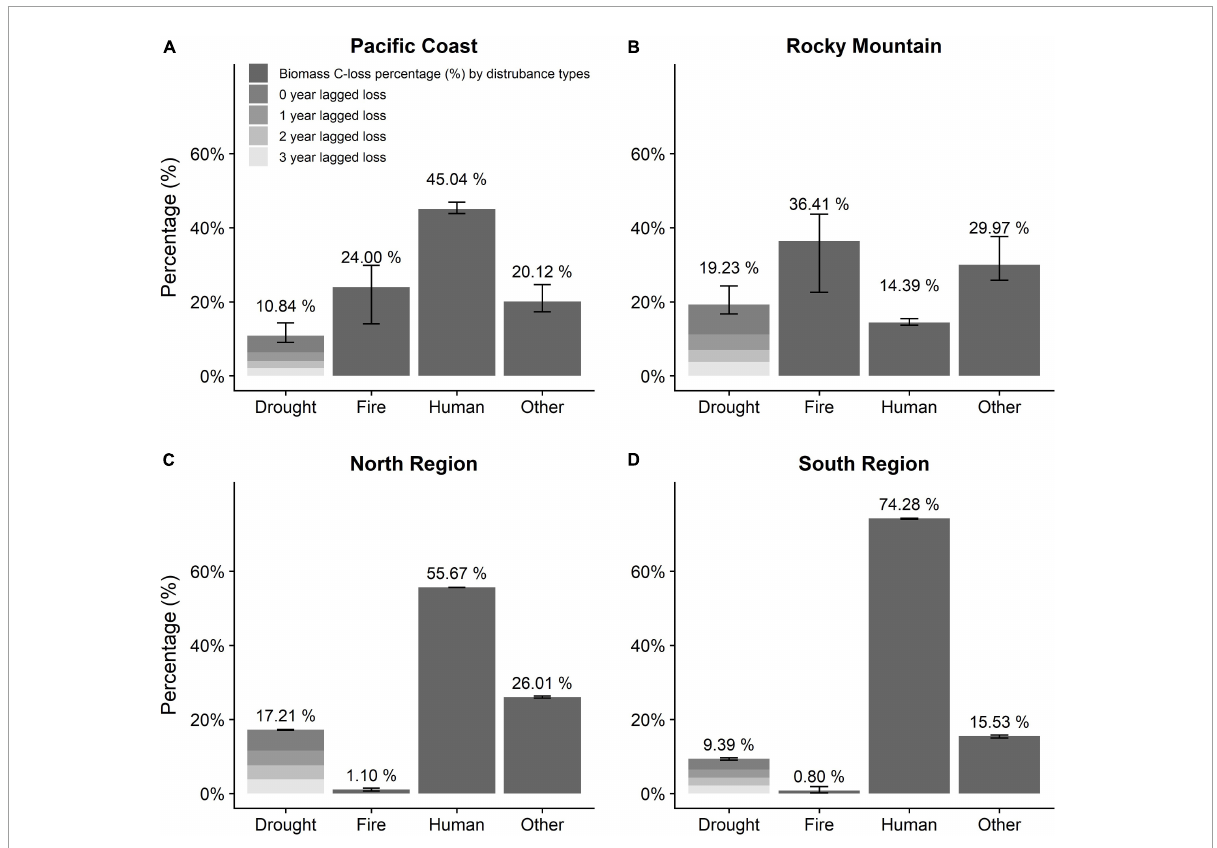
FIGURE4 Variation of aboveground biomass carbon loss/transfer from canopy trees in the four major forest service regions in CONUS for 2000–2014. (A) Pacific Coast region. (B) Rocky Mountain region. (C) North Region. (D) South Region. Numbers over the gray bars are the percentage of loss to each of the major disturbances, including fire, anthropogenic (especially timber harvest), drought-associated, and others. Error bars indicate the range of lower to upper estimates for each